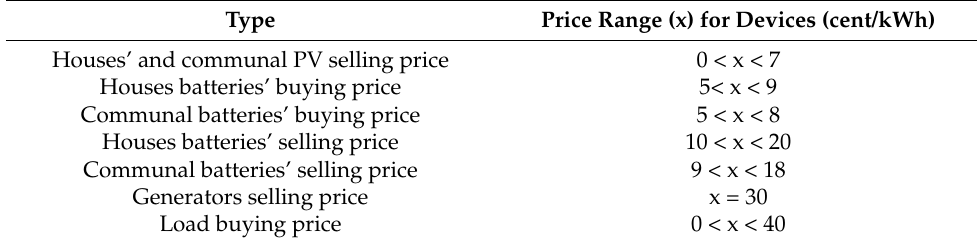
Table 3. Pricing for trading power between devices and